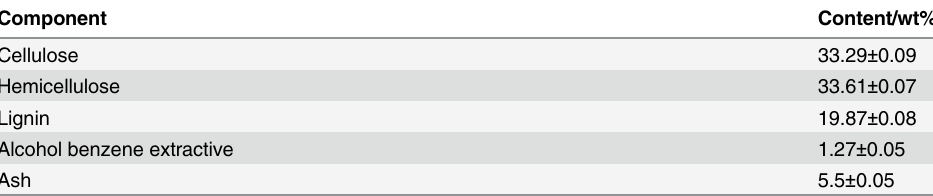
Table 1. Physical properties of coconut palm petiole fibers.